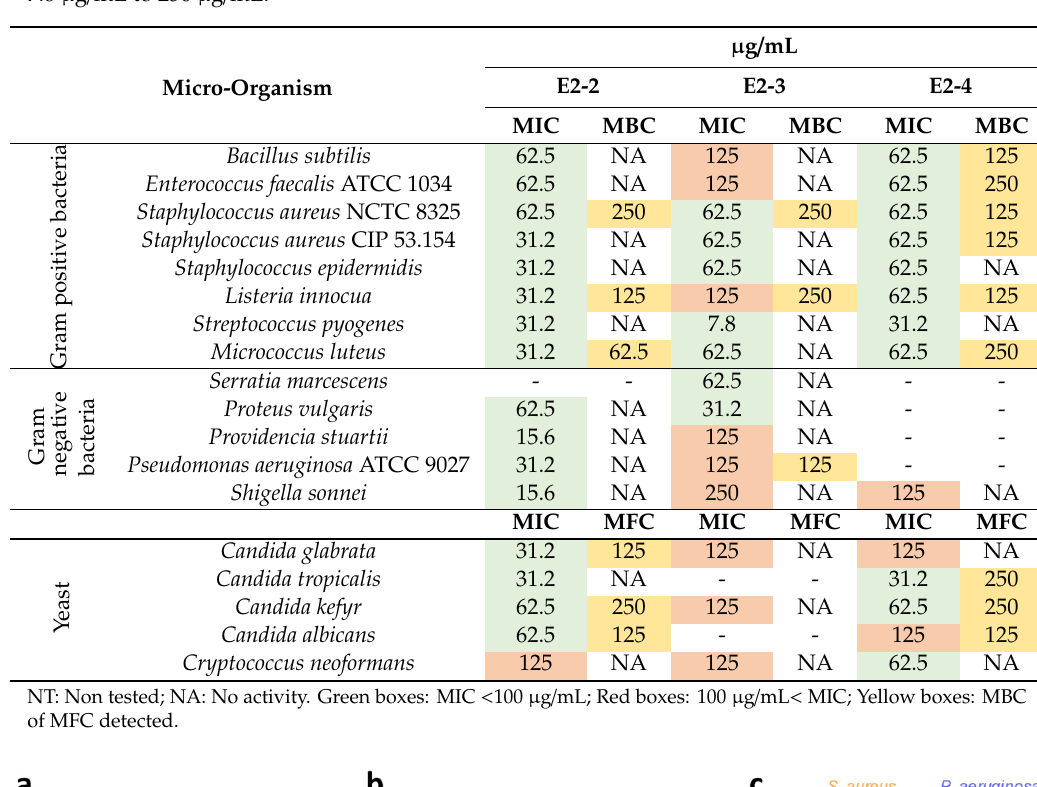
map is drawn in Figure 2. The 270 rows of the heat map correspond to the 13 C chemical shift buckets for which at least one signal was detected in at least one fraction of the extract. The higher the intensity of 13 C NMR peaks, the brighter the yellow color in the map. The map highlights strongly correlated 13 C NMR chemical shifts, belonging to the major chemical structures present in E2-4. These clusters of